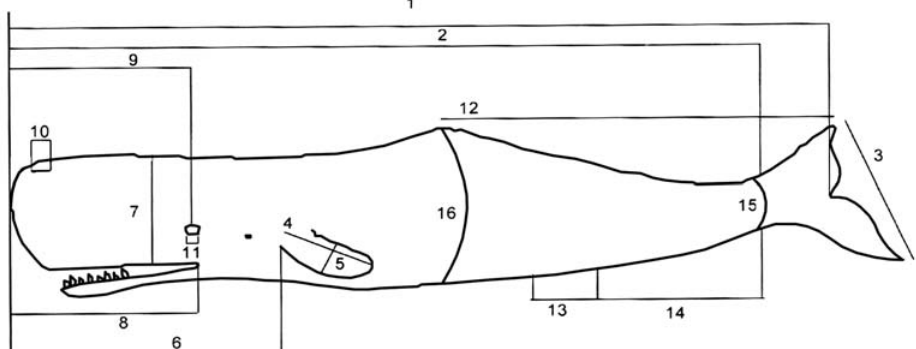
Figure 2. Morphometric parameters of stranded Sperm Whale 1 - Total length; 2 - Standard length; 3 - Fluke width; 4 - Flipper length; 5 - Flipper width; 6 - Snout to anterior insertion of flipper; 7 - Width of the snout; 8 - Snout to angle of mouth; 9 - Snout tip to centre of the eye; 10 - Blow hole length; 11 - Eye diameter; 12 - Dorsal hump to fluke tip; 13 - Length of the genital opening; 14 - Anus to base of the fluke; 15 - Width at the base of tail fluke; 16 - Height of the body